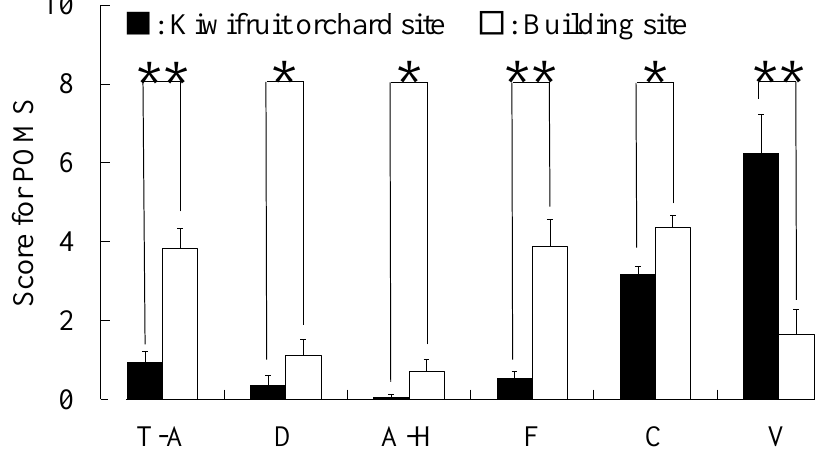
Figure 7. Comparison of Profile of Mood States (POMS) questionnaire results after 10-min viewing of a kiwifruit orchard site or a building site. T–A, tension–anxiety; D, depression; A–H, anger–hostility; F, fatigue; C, confusion; V, vigor. Data are expressed as the means ± SE; n = 17. * p < 0.05, ** p < 0.01 by the Wilcoxon signed-rank test